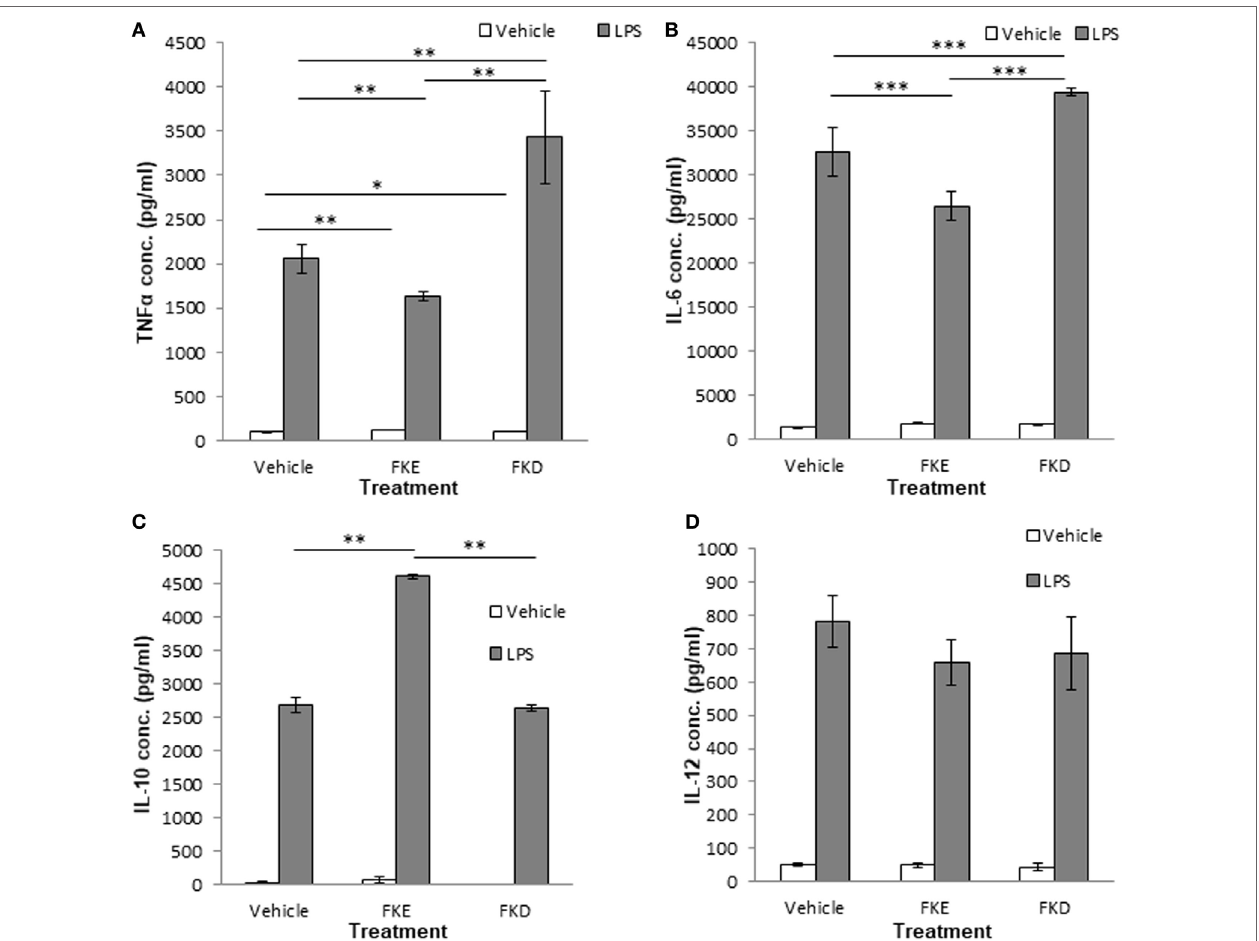
FigUre 5 | FKE peptides promote macrophage reprogramming. Mice undergoing peritonitis for 48 h were injected intraperitoneally (i.p.) with PBS, FKE, or FKD peptides (50 µM each). After additional 24 h, peritoneal macrophages were isolated and incubated ex vivo with lipopolysaccharide (LPS) (1 µg/ml, 24 h) or vehicle. Then, culture media were collected and its content of tumor necrosis factor α (TNF α ) (a) , interleukin (IL)-6 (B) , IL-10 (c) , and IL-12 (D) was determined by standard enzyme-linked immunosorbent assay. Results are representative (a,D) and averages ± SEM (B,c) from three experiments ( n = 4 per group). ***/**/*indicate statistically significant differences of P ≤ 0.005/ P ≤ 0.01/ P ≤ 0.05, respectively, by ANOVA with Tukey post hoc